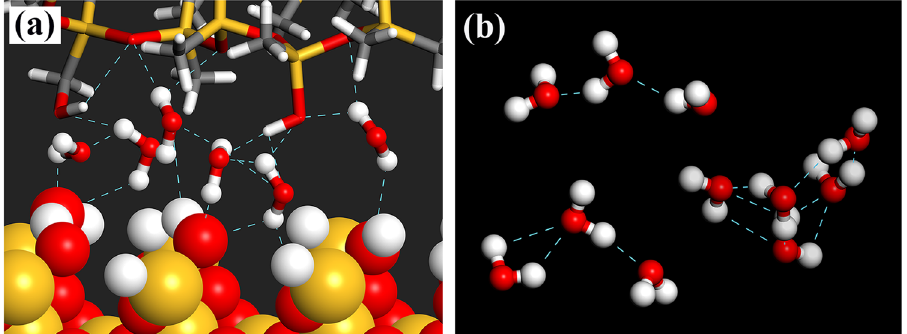
Fig. 14 H-bonds between H 2 O molecules and other polar groups. a Polar groups on the surface of the silica and PDMS matrix, and b hydroxyl groups of H 2 O